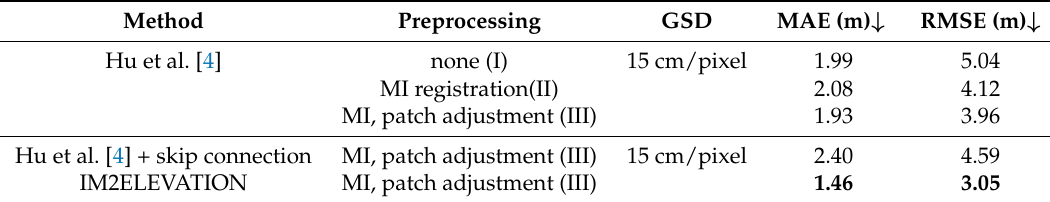
Table 3. DSM estimation accuracy measured by MAE and RMSE (lower vaues are better): Hu et al. [4] vs. IM2ELEVATION (proposed) with different types of registration between Lidar and aerial data. The loss employs λ = 1, µ = 1 for all methods. Best results in bold.